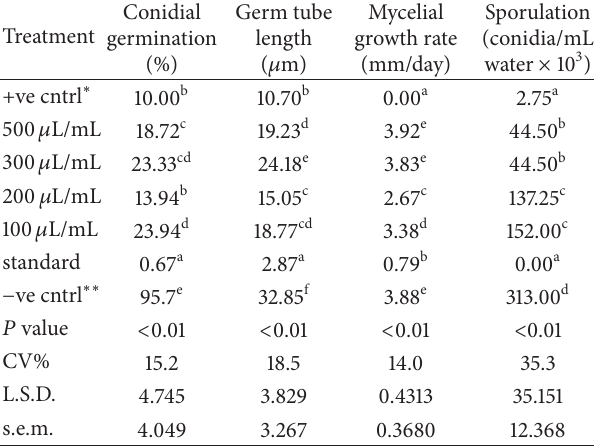
Table 1: Effect of different concentrations of cow urine, copper oxychloride, and distilled water on the growth characteristics of F. lateritium